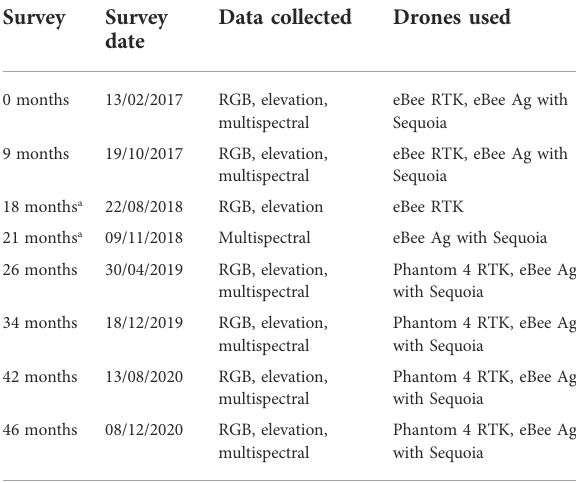
TABLE 1 Summary of data collected on drone fl ights at Fish Fry Flat rehabilitation site between 2017 and 2020. RTK = Real Time Kinematic andreferstotheability of thedronetocollect locationand elevation